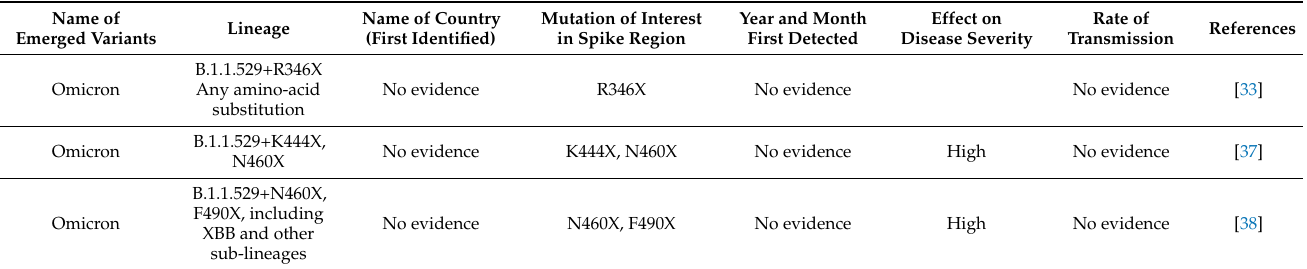
Table 5. Variants under